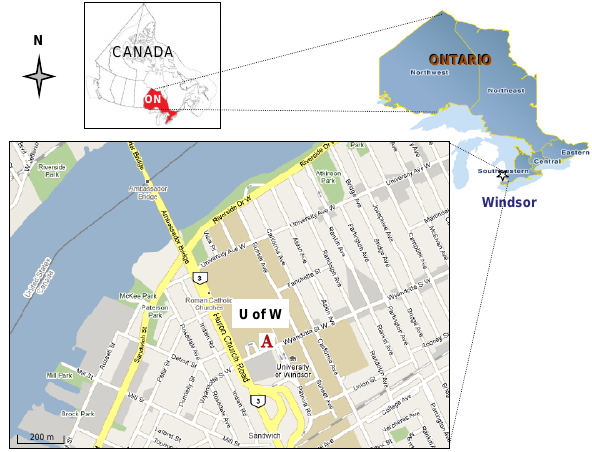
Fig. 1. Map of sampling location at the University of Windsor, Windsor, Ontario, Canada (Letter A indicates the sampling site. Base maps adapted from Google Maps Canada, 2009).